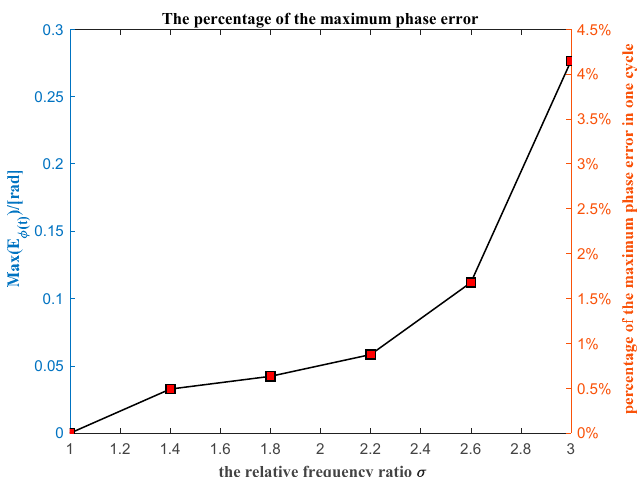
ff erent relative frequency ratios.